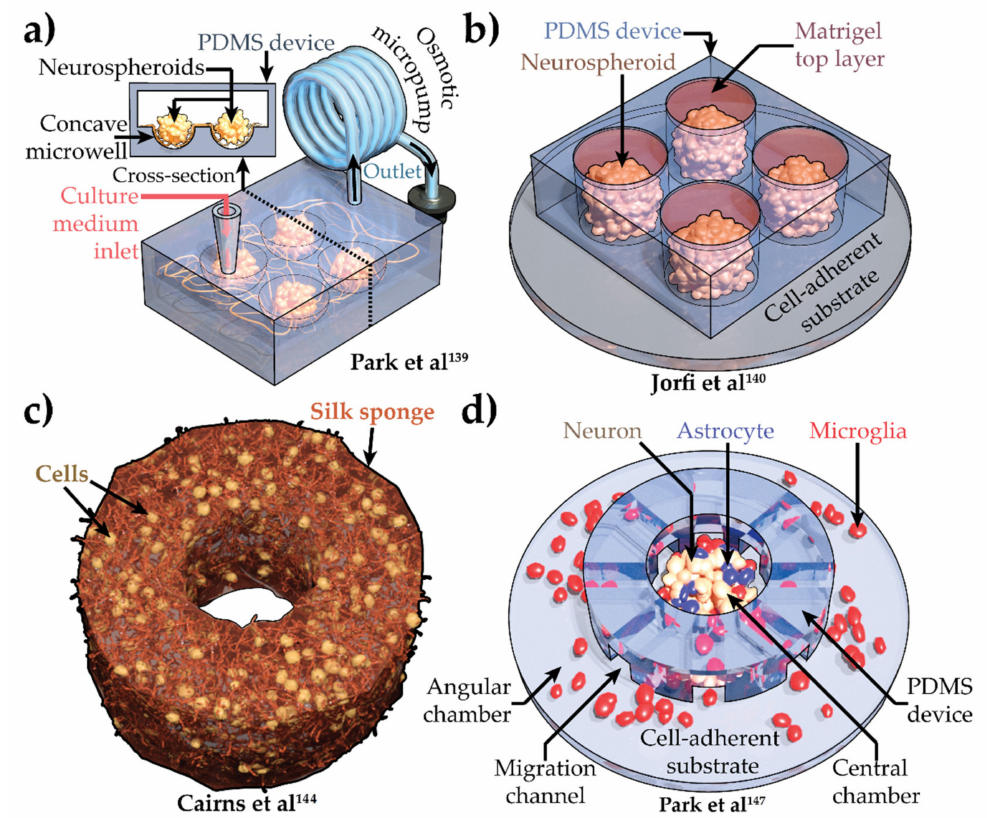
Figure 3. Engineered 3-dimensional (3D) human induced pluripotent stem cell–derived Alzheimer’s disease models. ( a ) 3D culture based microfluidic chip with interstitial flow of culture medium [139]. ( b ) Engineered neurospheroids in PDMS microwell array [140]. ( c ) Silk sponge-embedded 3D neuronal culture [144]. ( d ) 3D Neuron (brown), astrocyte (blue), and microglia (red) tri-culture system in microfluidic device [147]. PDMS,